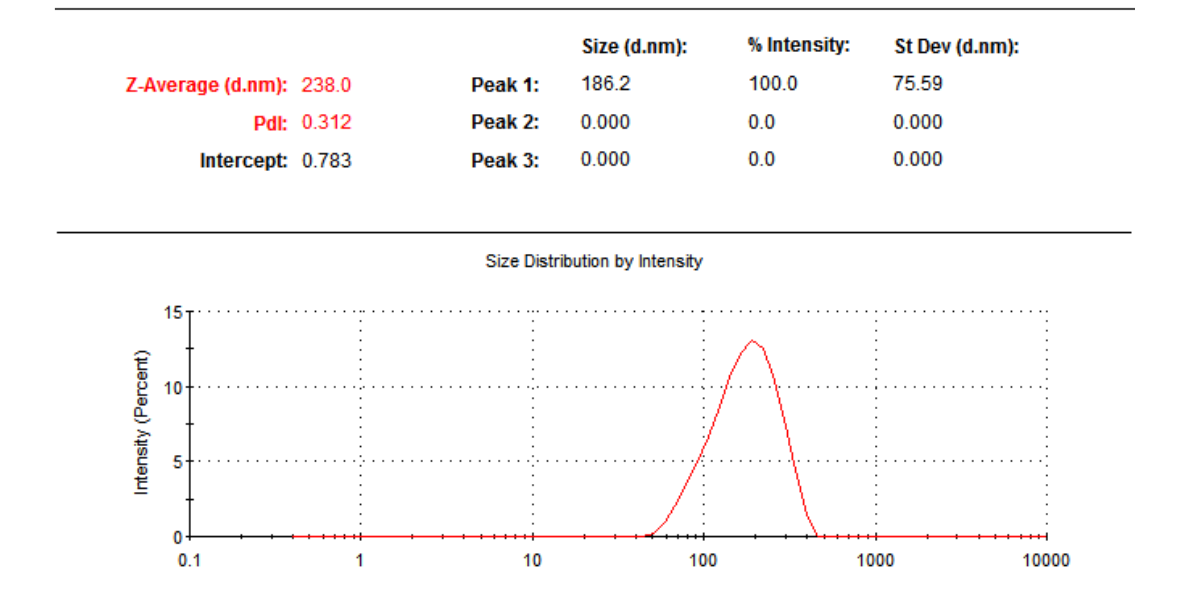
Figure 2. Z- Average and Size distribution of green TiO 2 nanoparticles. Figure 2. Z ‐ Average and Size distribution of green TiO 2 nanoparticles.